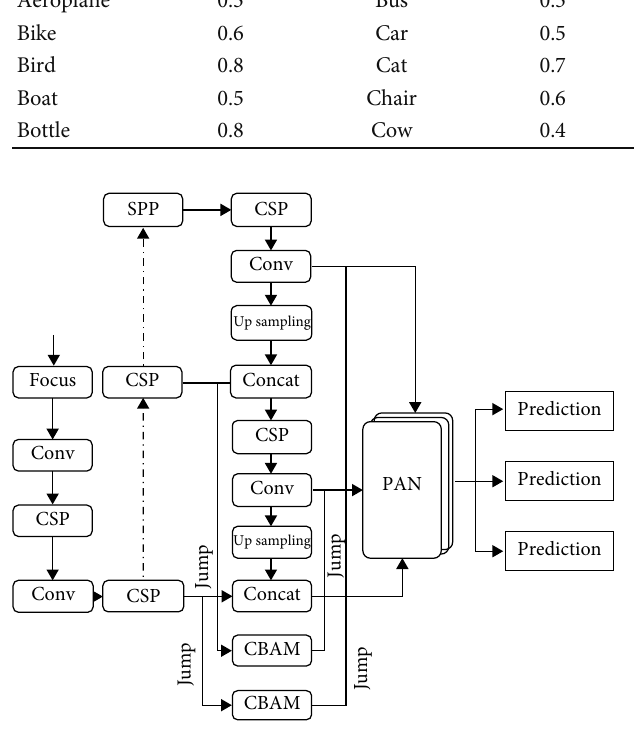
Figure 3: Improved YOLOv5